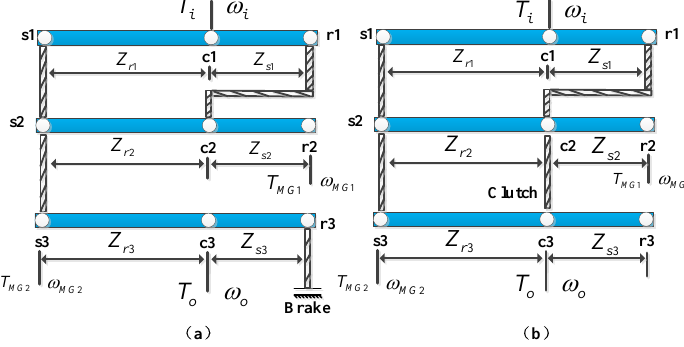
Figure 4. Lever diagram of the hybrid HDV with PST for each mode: ( a ) EVT Mode 1; and ( b ) EVT Mode 2.